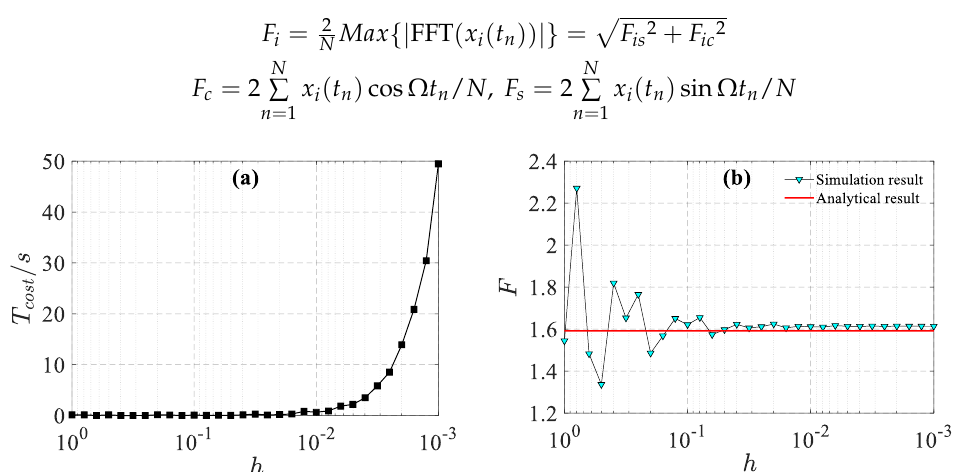
Figure 17. Effect of step size on simulated results of output steady-state amplitude and time cost ( a ) ( a ) T = 100, ( b ) ∆ 2 = 1. = 100 T , ( b ) 2 1  = .